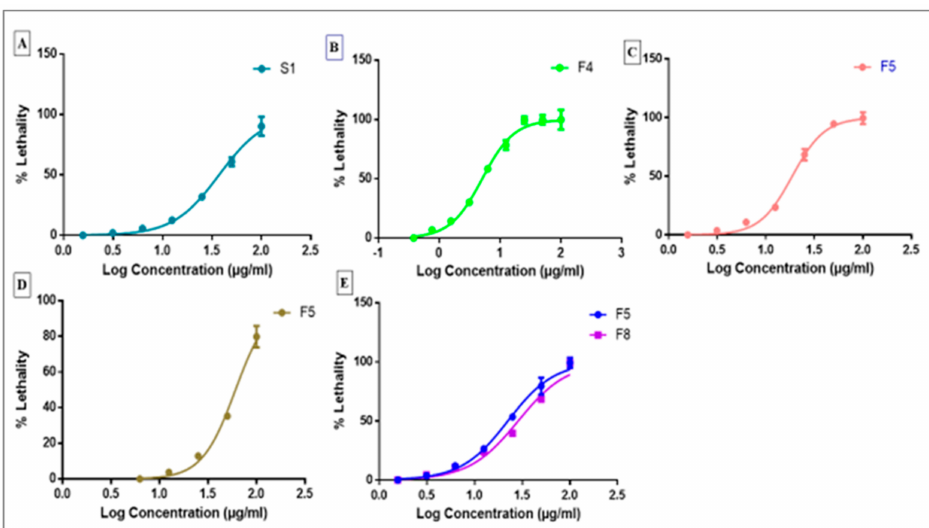
Figure 3. Dose–response curves for fractions S1 on HCT116 cells ( A ), F4 on HePG2 cells ( B ), F5 on HePG2 cells ( C ), F5 on A549 cells ( D ), and F5 and F8 on MCF7 cells ( E ). The dose–response curves were used to determine LC50, LC90, and Hill coe ffi cient values. Table 4. LC50 and LC90 for the fractions that showed lethality ≥ 75%. Fraction Cancer